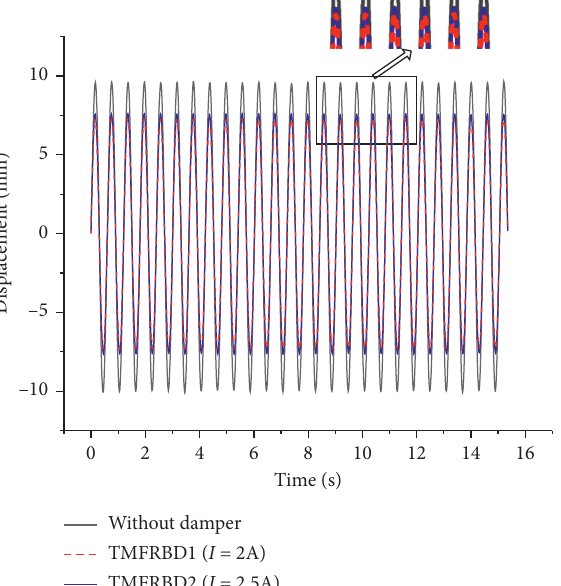
Figure 13: The displacement response curve under 1.66Hz.